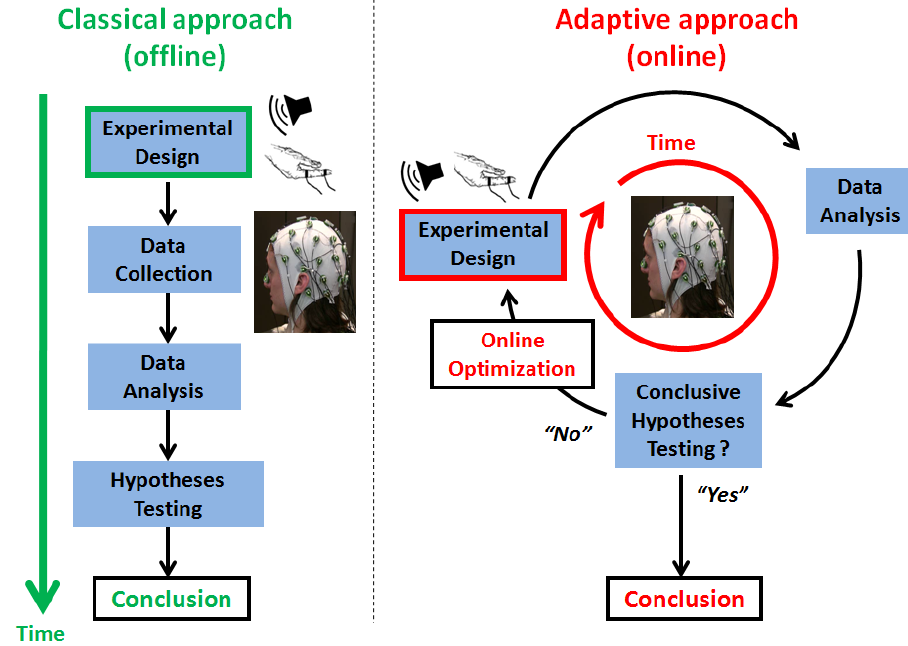
Figure 1. A schematic illustration of the adaptive versus classical experimental design approaches. The classical approach ( left ) is characterized by a sequential ordering of the main experimental steps: experimental design specification occurs prior to data acquisition, which is followed by data analysis and hypothesis testing. In contrast, the adaptive approach ( right ) operates in real time and proceeds with design optimization, data acquisition and analysis at each experimental stage or trial. The online approach enables hypothesis testing to be optimized at the individual level by adapting the experimental design on the basis of past observations. This is the general principle of adaptive design optimization (ADO), which can be extended to advanced computational models of electrophysiological responses thanks to brain-computer interface (BCI) technology, with the aim of optimizing experimental conclusions and the time-to-conclusion in cognitive and clinical